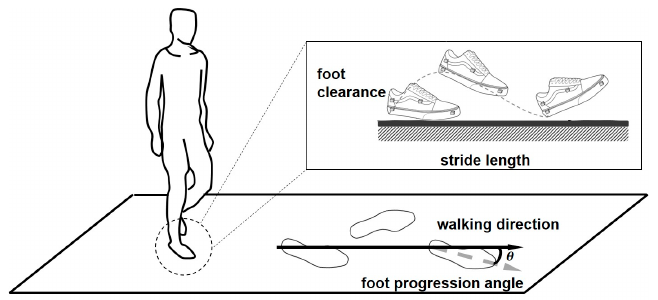
Figure 1. Schematic illustration of the UWB sensor system to analyze gait characteristics.